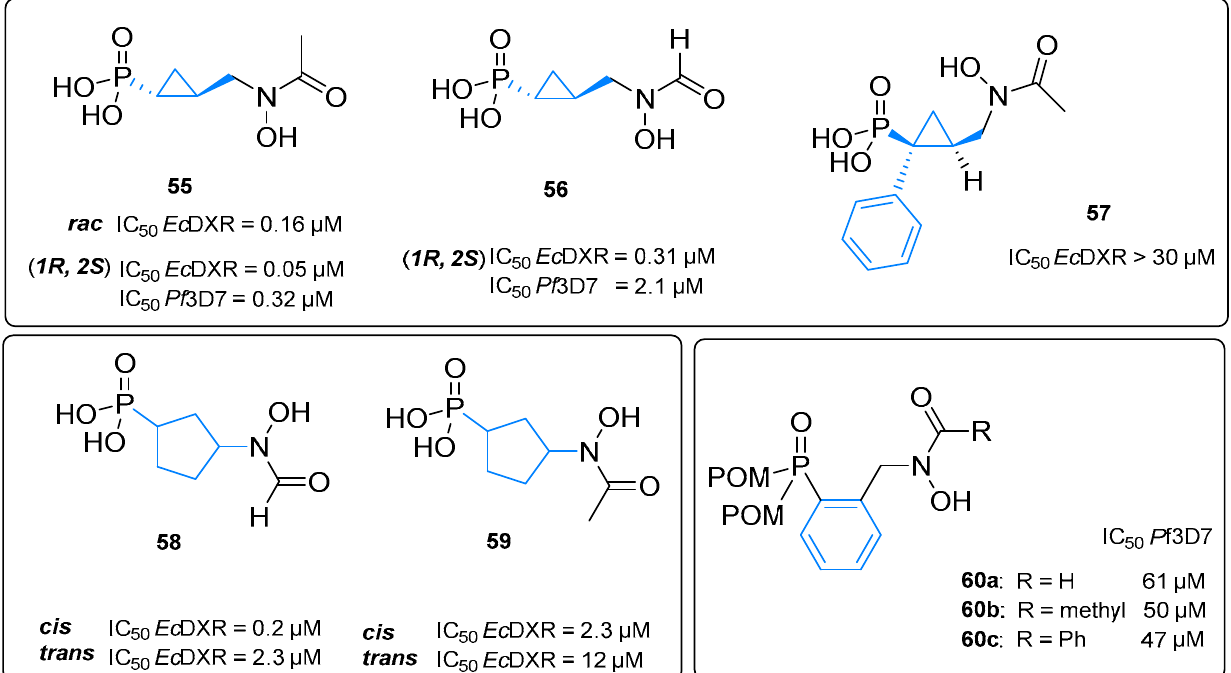
Figure 16. Biological activity of conformationally restricted analogs 55 – 60 .